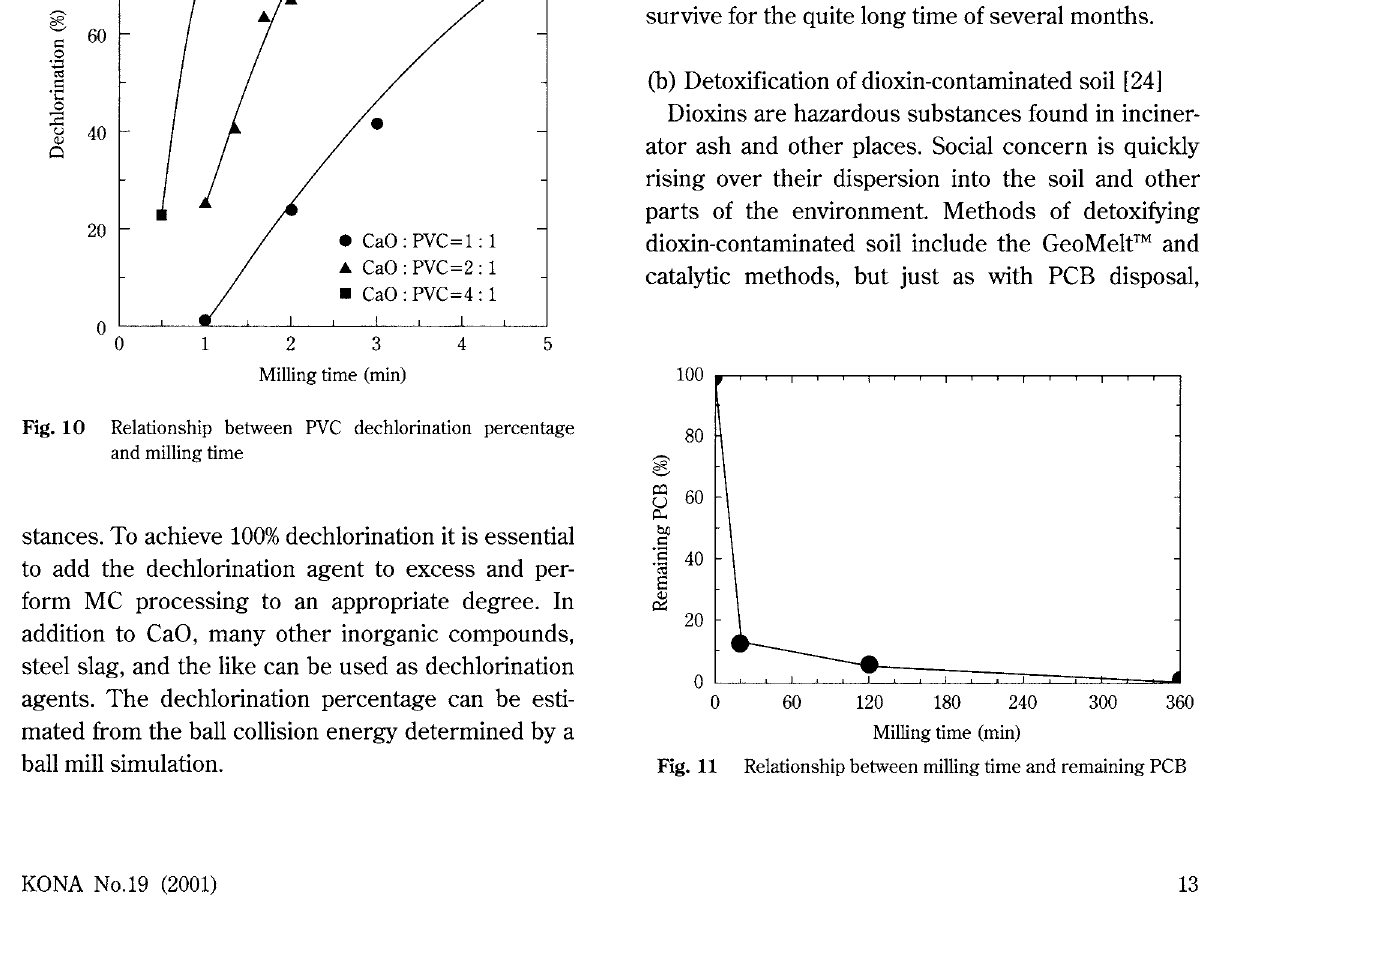
XRD patterns of MC-processed CaO-PVC mixture